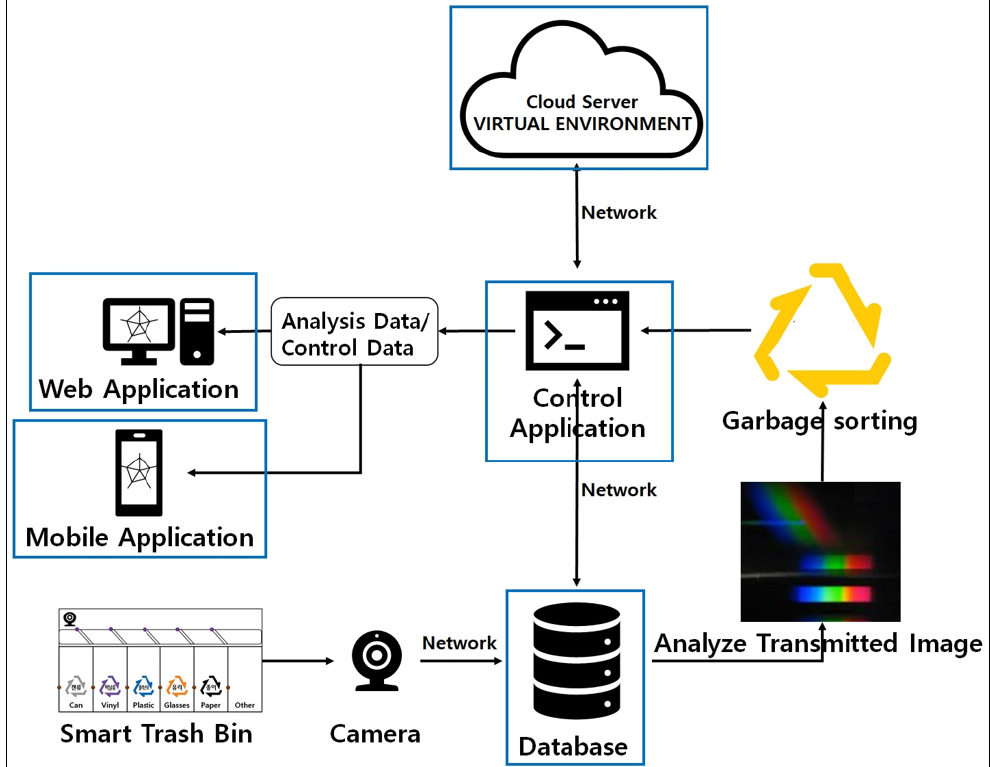
Figure 12. Future work plans.